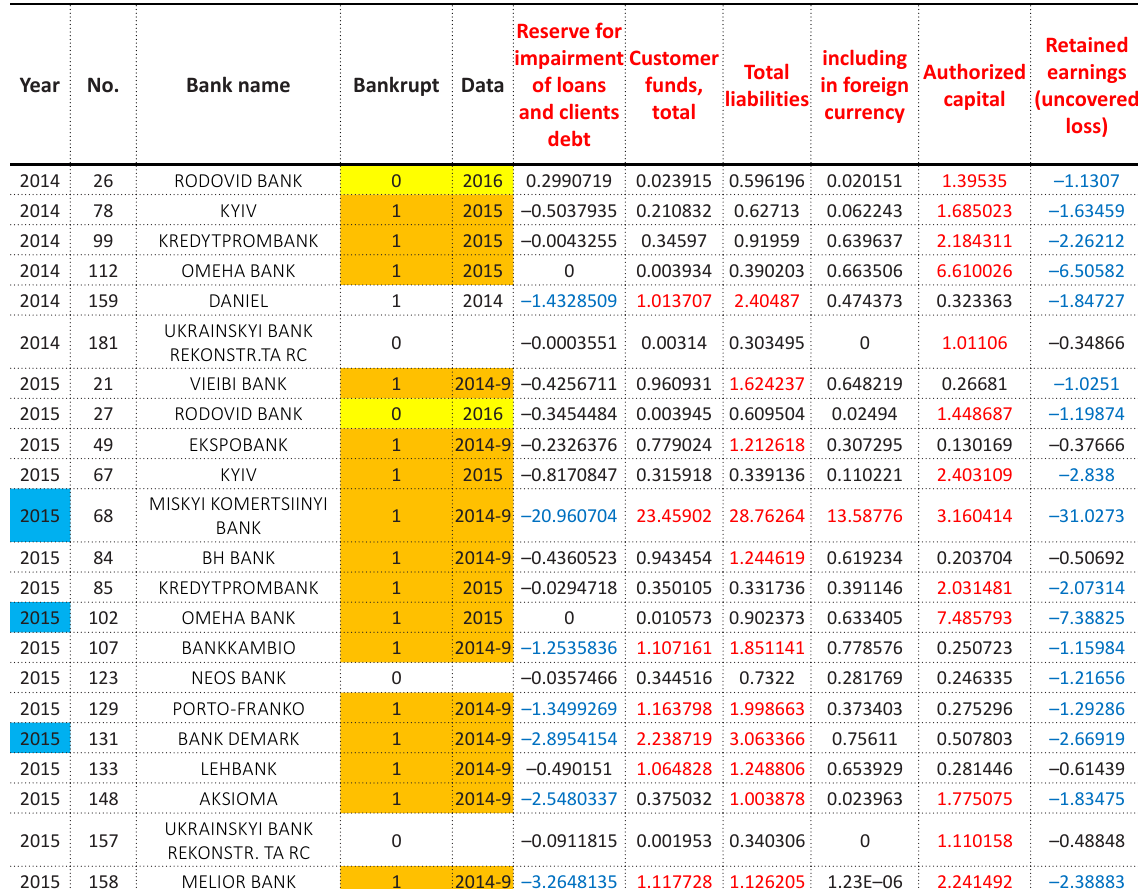
Source: Developed by the